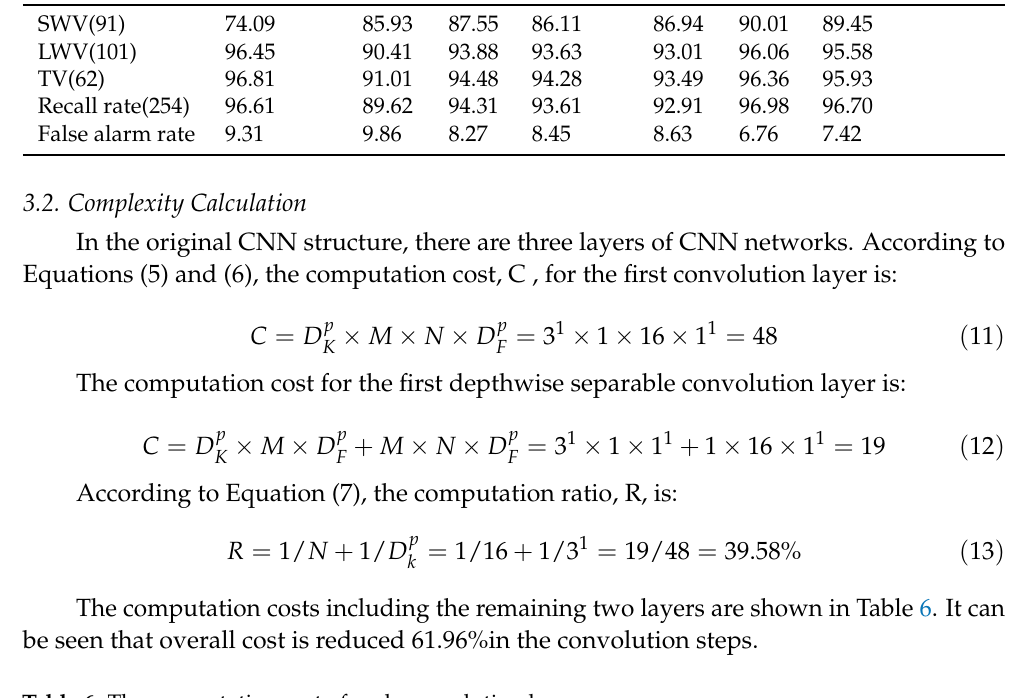
Table 6. The computation cost of each convolution layer.